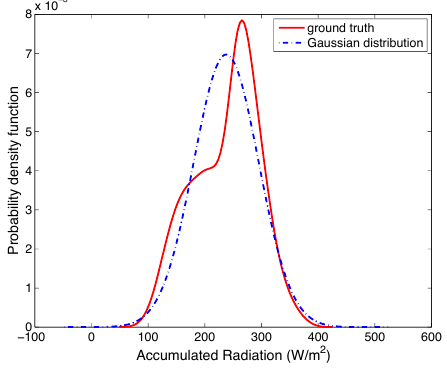
Figure 2. The probability density of S h ( 10 ) is close to a Gaussian distribution.